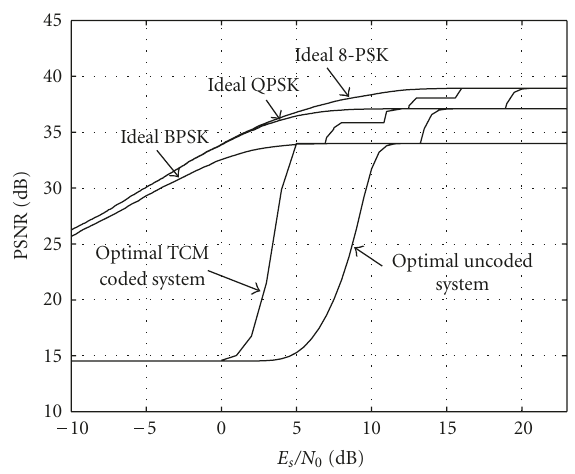
Figure 5: The best PSNR versus capacity-achieving E s /N 0 perfor- mance of using our JSCC system for transmitting the SPIHT com- 512 Lena image using 65,536 pressed 512 (cid:0)